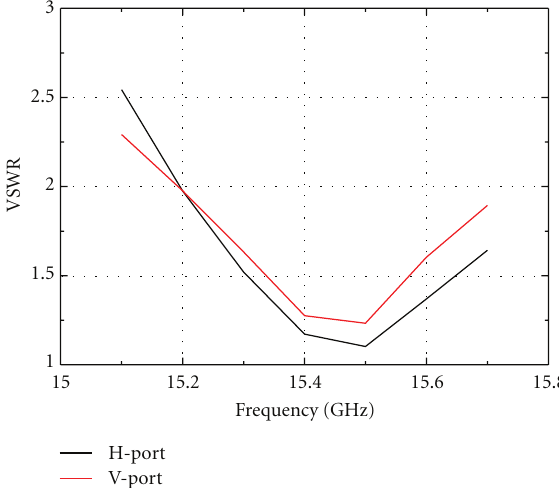
Figure 4: The VSWR of the dual-polarized microstrip antenna